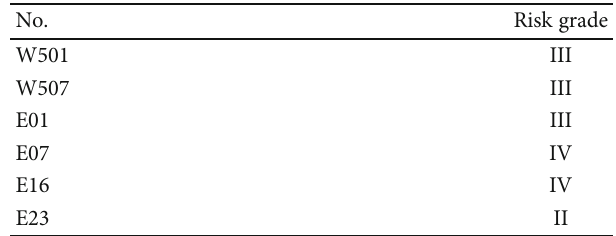
Figure 3: The stope of Xin-Qiao Mine. Table 5: Analytically obtained risk grade of stopes ’ Table 3: Index values.